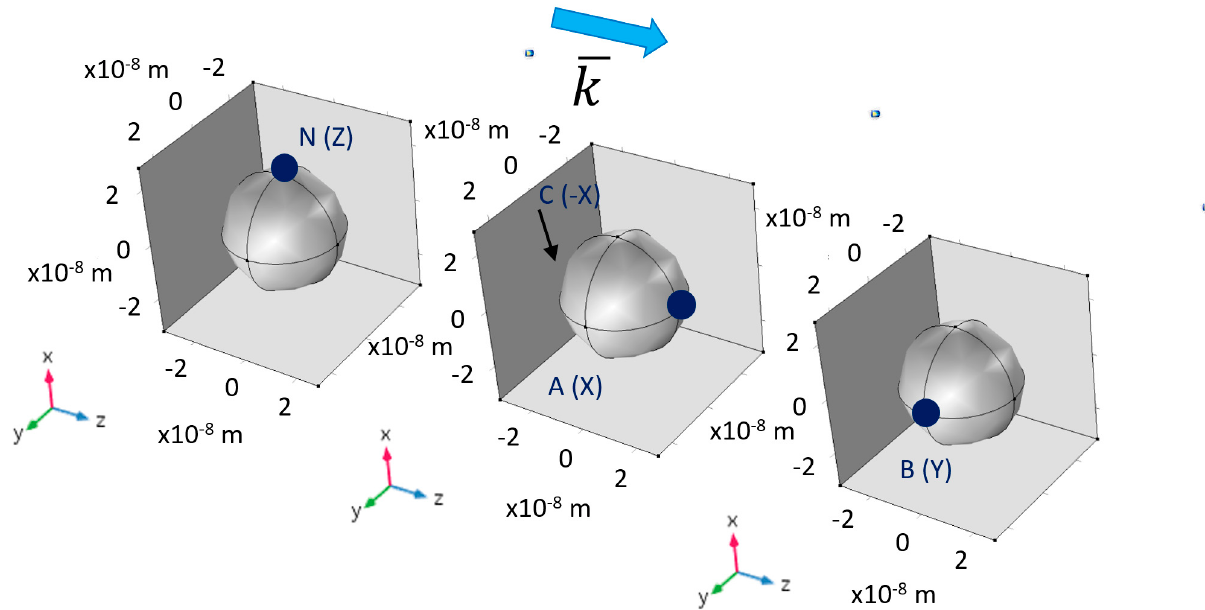
Figure 6. Illustration example of Comsol simulation of the points (N), (A), and (B). The field enhancement is displayed at the points (N), (A), and (B) and some of their polar pairs of the nano-spheres.